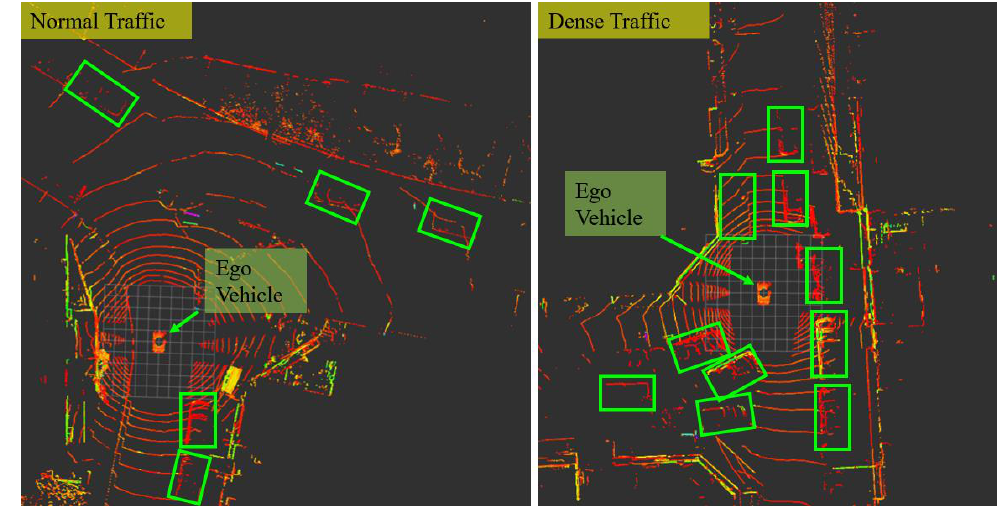
Figure 4. Scenarios with different traffic conditions. The green boxes indicate the surrounding dynamic vehicles. The left figure shows the scenario with normal traffic and right figure with dense traffic.